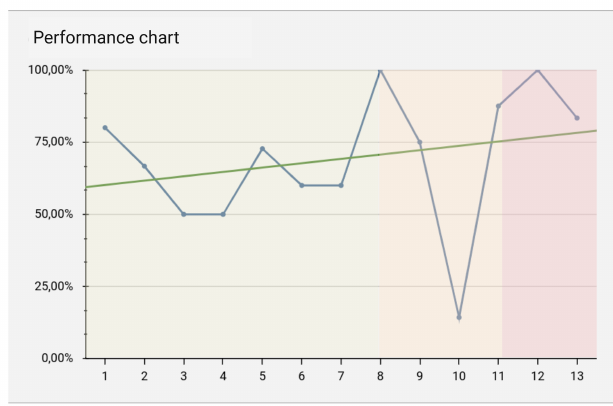
Figure 16. Performance graph with the patient trend line. Source: Author